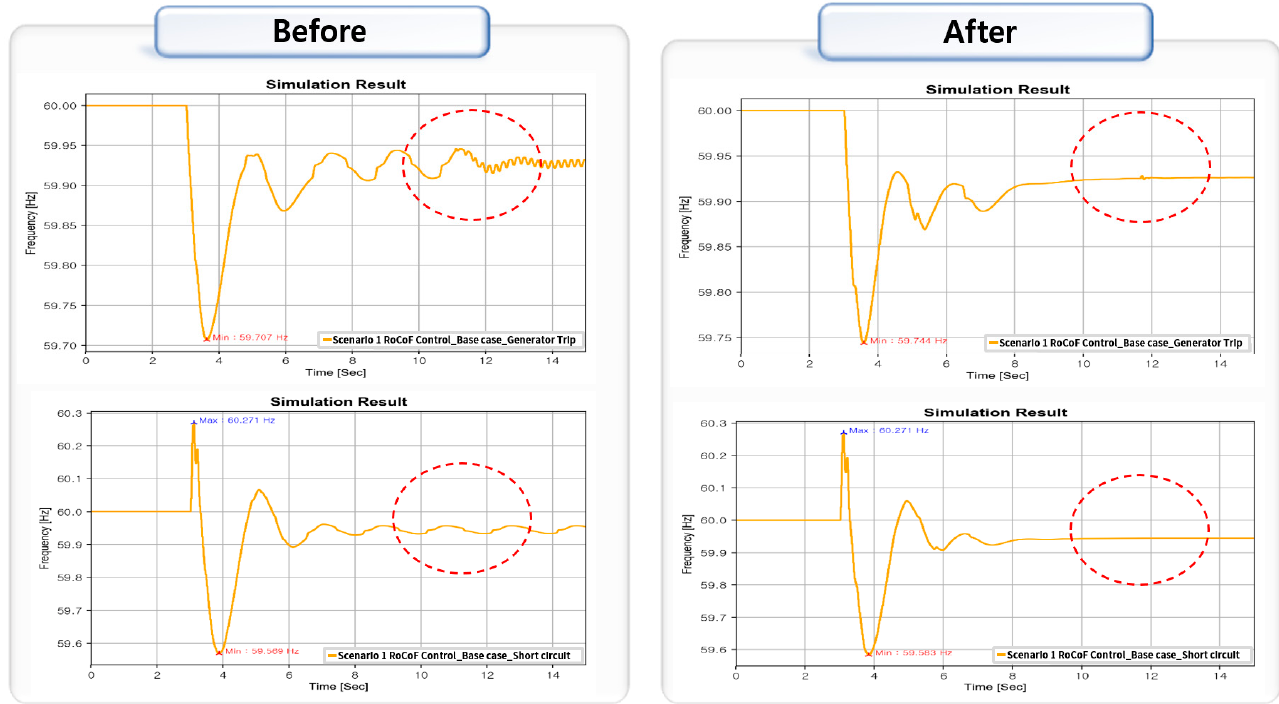
Figure 17. Effect of applying the ESS No.2